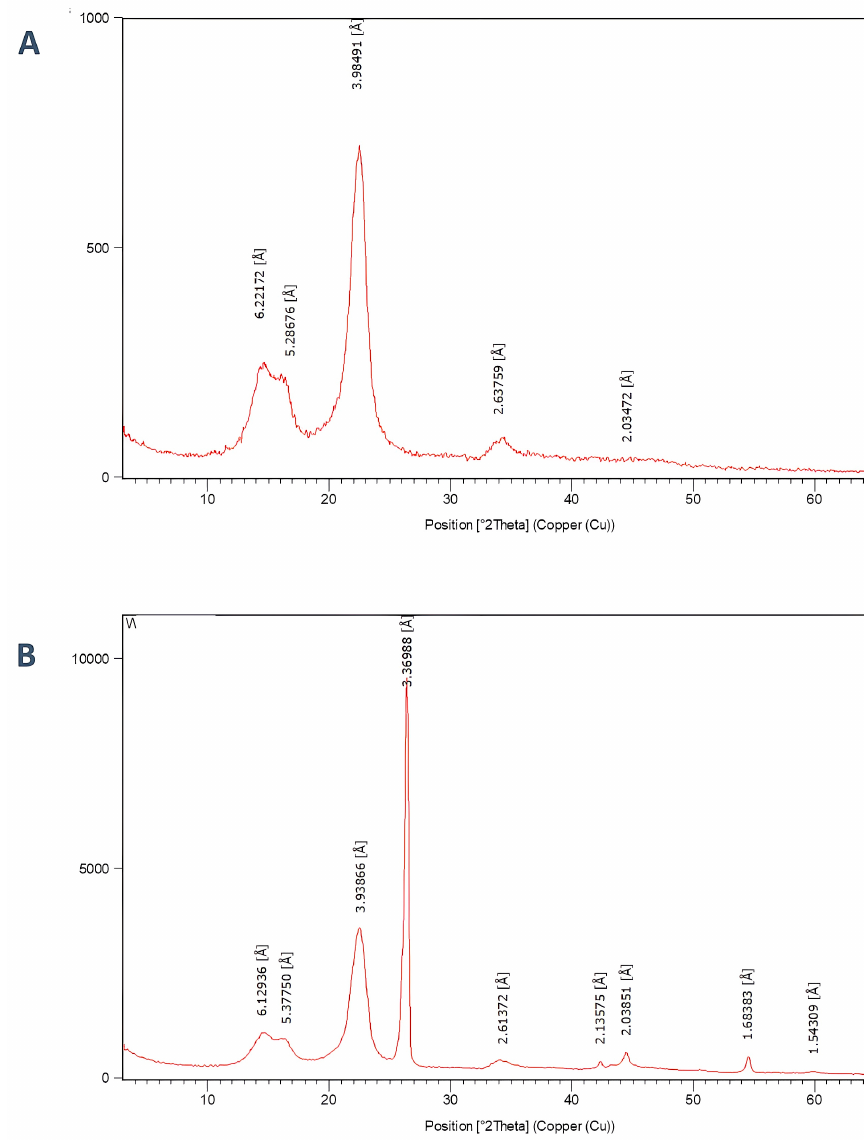
Figure 7. XRD patterns of untreated cotton ( A ) and graphite-based cotton ( B